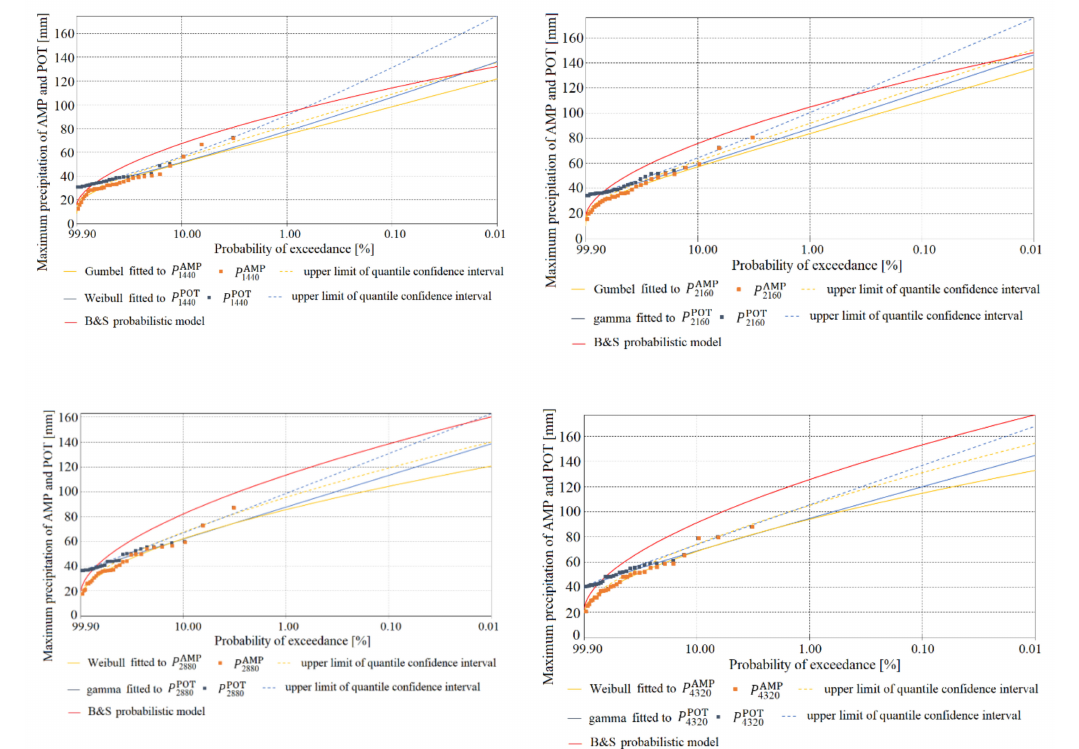
Figure 7. Plots of functions of probability of exceedance for the random variables P AMP τ and P POT τ , where τ = {1440, 2160, 2880, 4320} min, for the most credible probability distributions, with indication of upper limits of quantile confidence intervals according to the PMAXTP method, compared with the model of Bogdanowicz and Stach ý , for the Chojnice meteorological station.